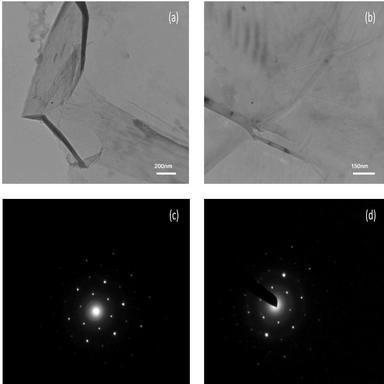
(a, b) TEM images of the nitrogen-doped graphene in different scales after removing the nickel foam, and (c, d) HRTEM images of nitrogen-doped graphene.